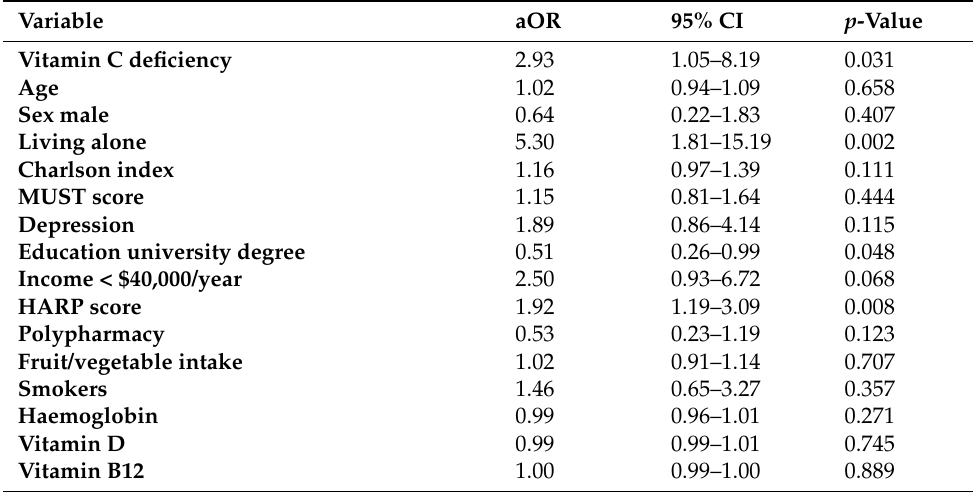
Table 2. Logistic regression model comparing patients with vitamin C deficiency with non-vitamin C deficient patients and cognitive impairment as an outcome